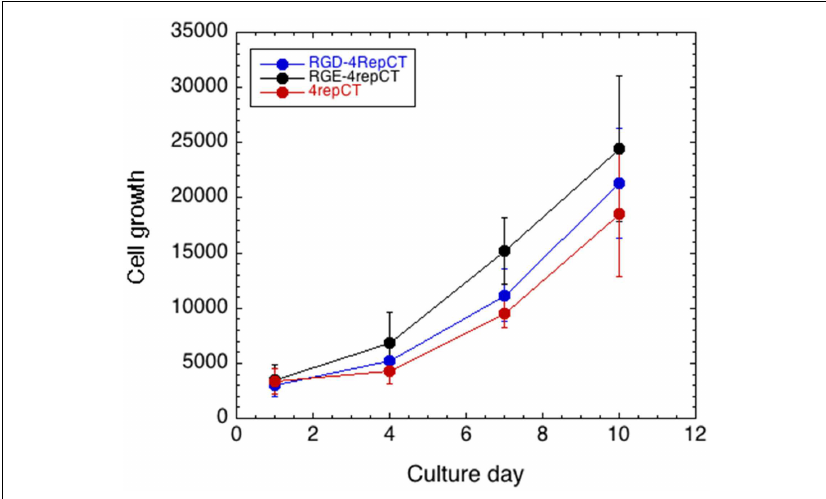
FIGURE 1 | Cell growth on functionalized spider silk matrices. Growth curves for primary human fibroblasts grown on RGD-4RepCT, RGE-4RepCT, and 4RepCT films, respectively, as described inWidhe et al. (2013). Cell growth was monitored with Alamar Blue cell viability assay. Each scaffold type was analyzed in hexaplicates, and the results are representative of three independent